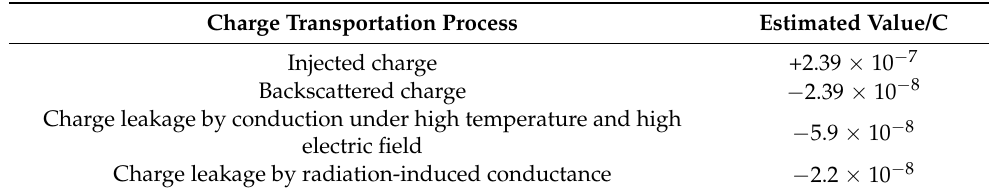
Table 5. Calculation results of charge deposition and release per unit time of PI under 5 µ A